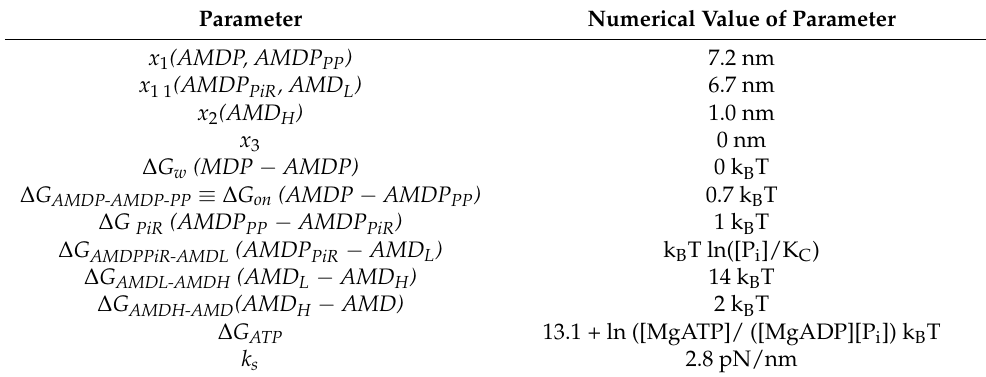
Table 1. Parameter values a for model in Figure 1 determining the shape of free energy diagrams for simulation of contractile properties of fast mammalian muscle at 30 ◦ C.